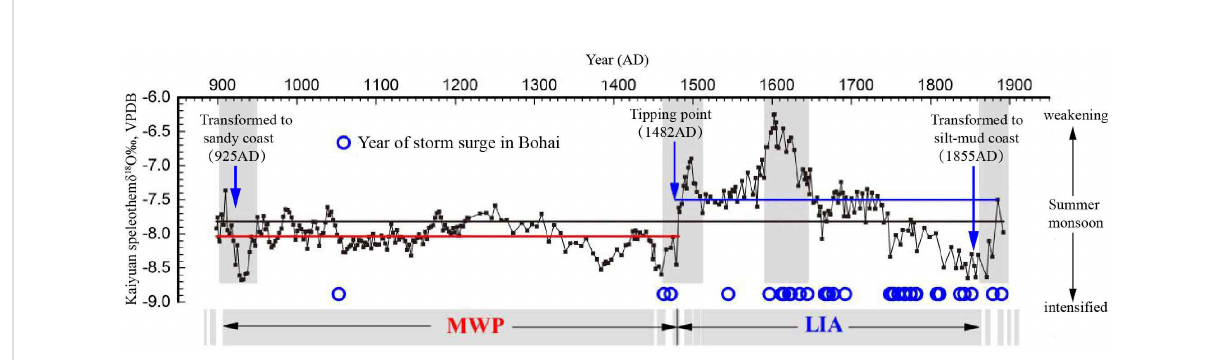
FIGURE 6 d 18 O record from Kaiyuan cave (Wang et al., 2015), showing changes in summer monsoon intensity during 892 – 1894 AD and the occurrence of storm surges in the Bohai Sea (Liu and Zhang, 1991). The four vertical gray bars indicate the abrupt climatic